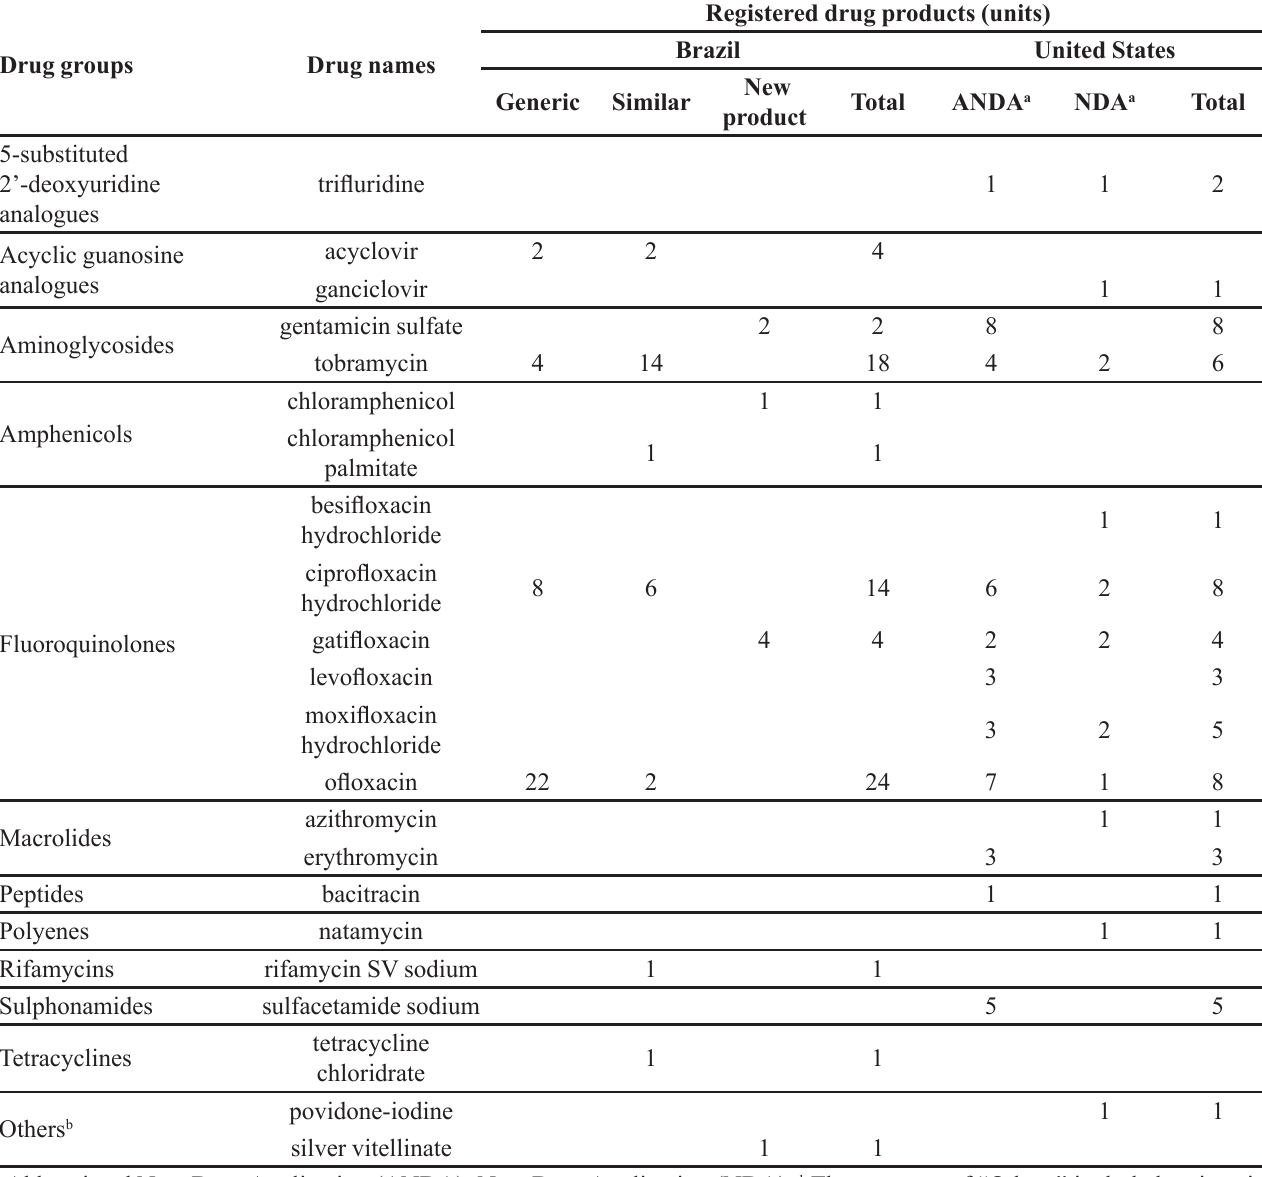
TABLE I - Comparison of drug substances groups registered as simple ophthalmic products in Brazil and in the United States